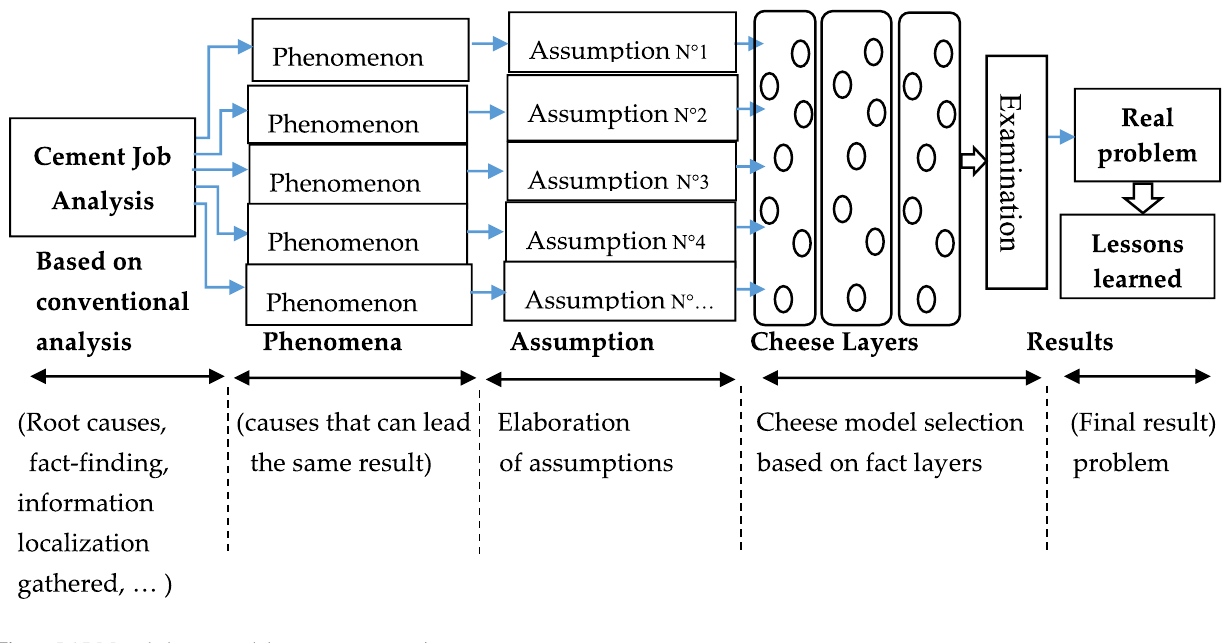
Fig. 4 PABM and cheese model process